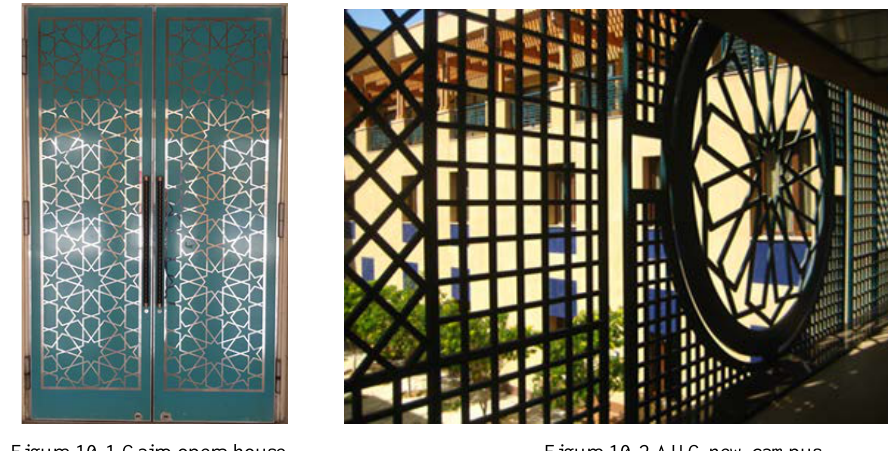
Figure 10-1 Cairo opera house Figure 10-2 AUC new campus